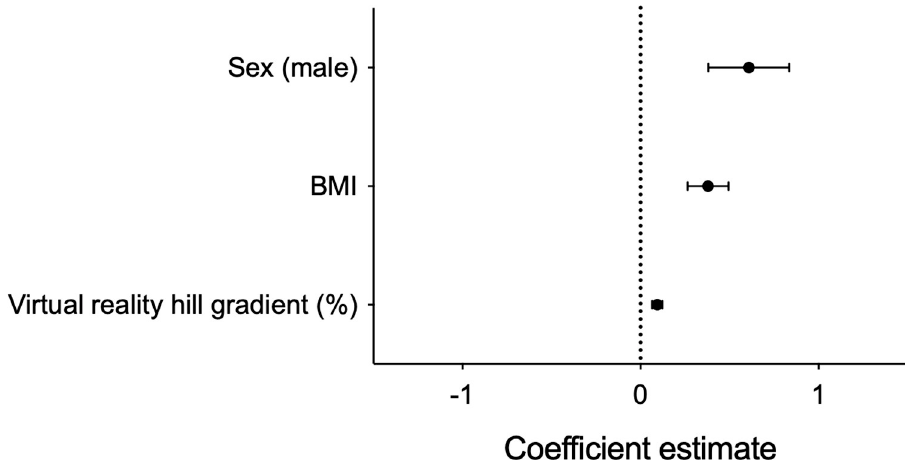
Fig 5. Virtual reality hill gradient, BMI, sex (male) are independent predictors of physical effort (i.e., the power).